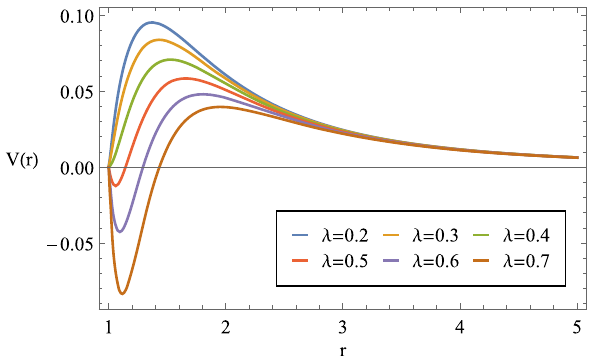
Fig. 1 The effective potential of the scalar field in asymptotical flat schwarzschild black hole with different values of